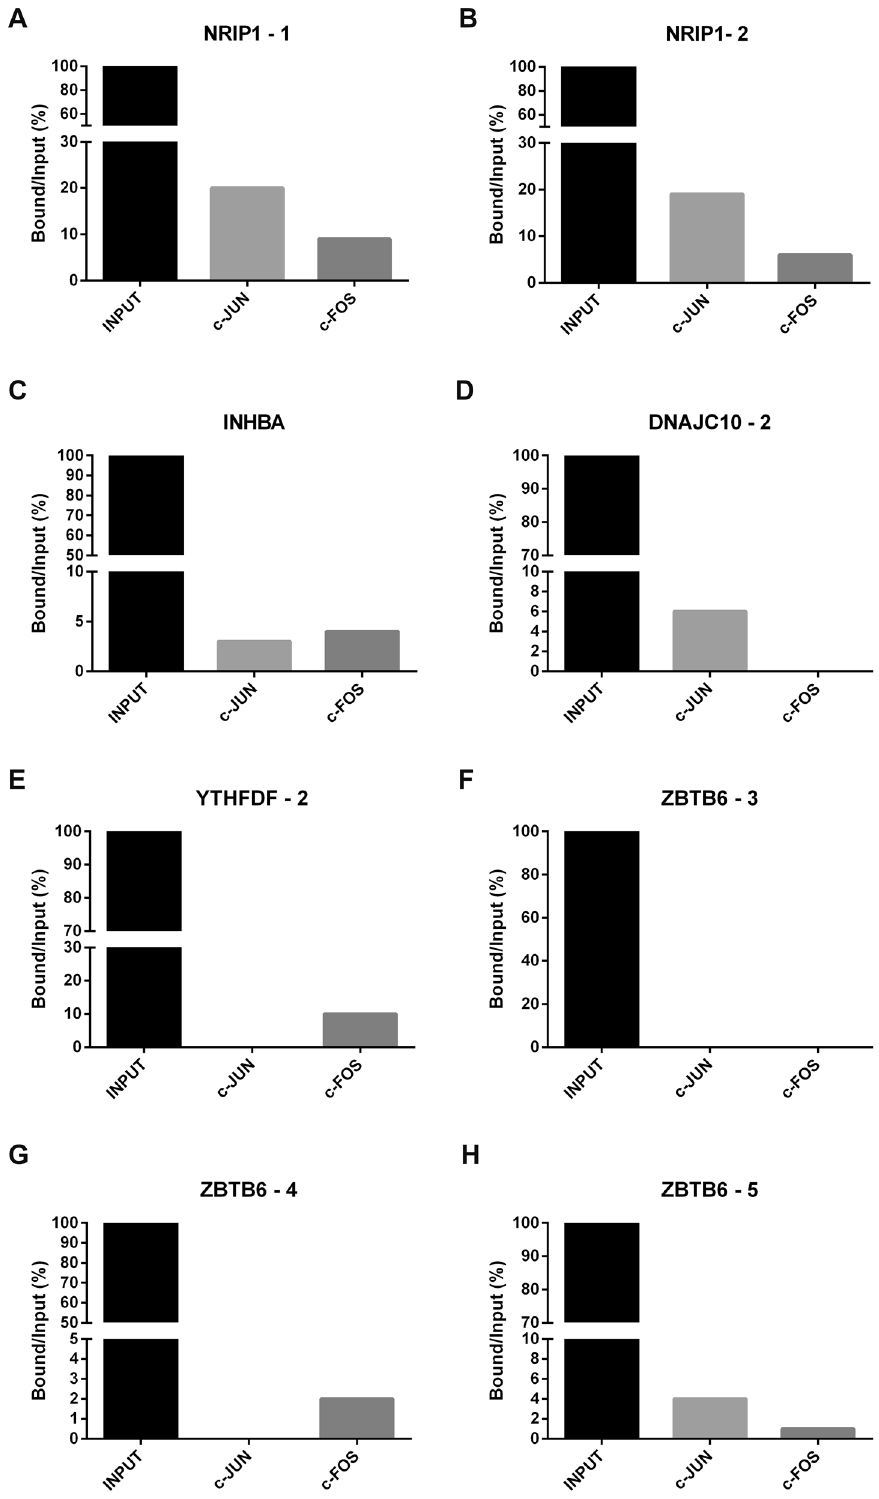
Figure 3. Chromatin immunoprecipitation assay (ChiP) with C-JUN and C-FOS followed by RT-qPCR of the predicted AP-1 binding sites in the DNAJC10, INHABA, NRIP1, YTHDF-3 and ZBTB6 gene promoters. Using the C-JUN antibody, we observed specific binding to NRIP1 at the consensus binding sites from AP-1 ( A,B ), consensus site from INHABA ( C ), consensus site 2 from DNAJC10 ( D ) and consensus binding site 5 from the ZBTB6 gene promoter ( H ). Using the C-FOS antibody, we also observed specific binding to NRIP1 at the consensus binding sites from AP-1 ( A,B ), consensus site from INHABA ( C ), consensus site from YTHDF-3 ( E ) and consensus binding sites 4 and 5 from the ZBTB6 gene promoter ( G,H ). No binding was observed at consensus binding site 3 from the ZBTB6 gene promoter ( F ). The bar graphs show the fold-change at each site compared to the binding of the input